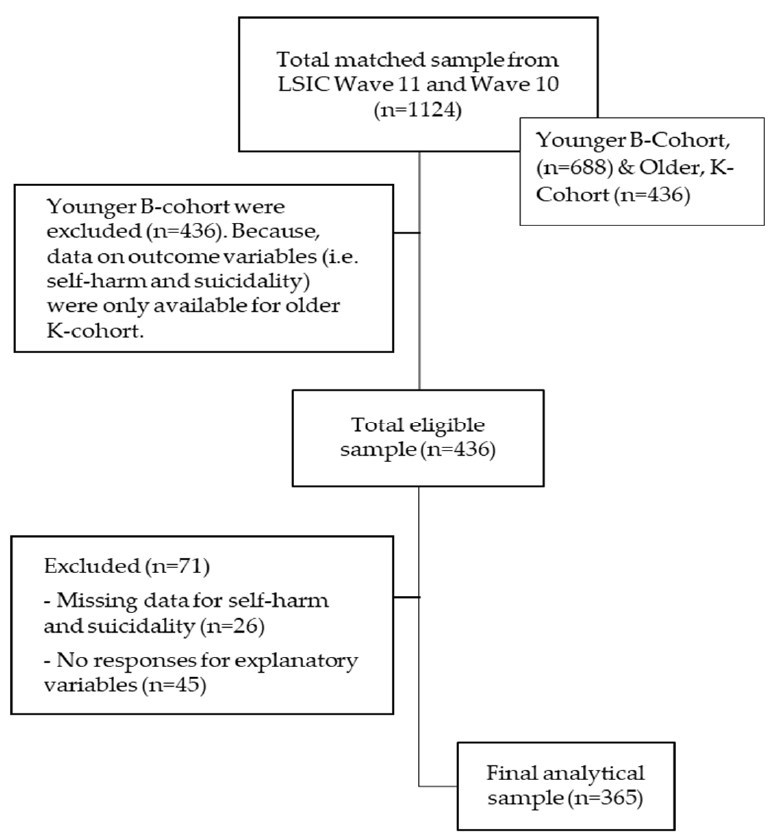
Figure 2. Flow chart for sample selection.